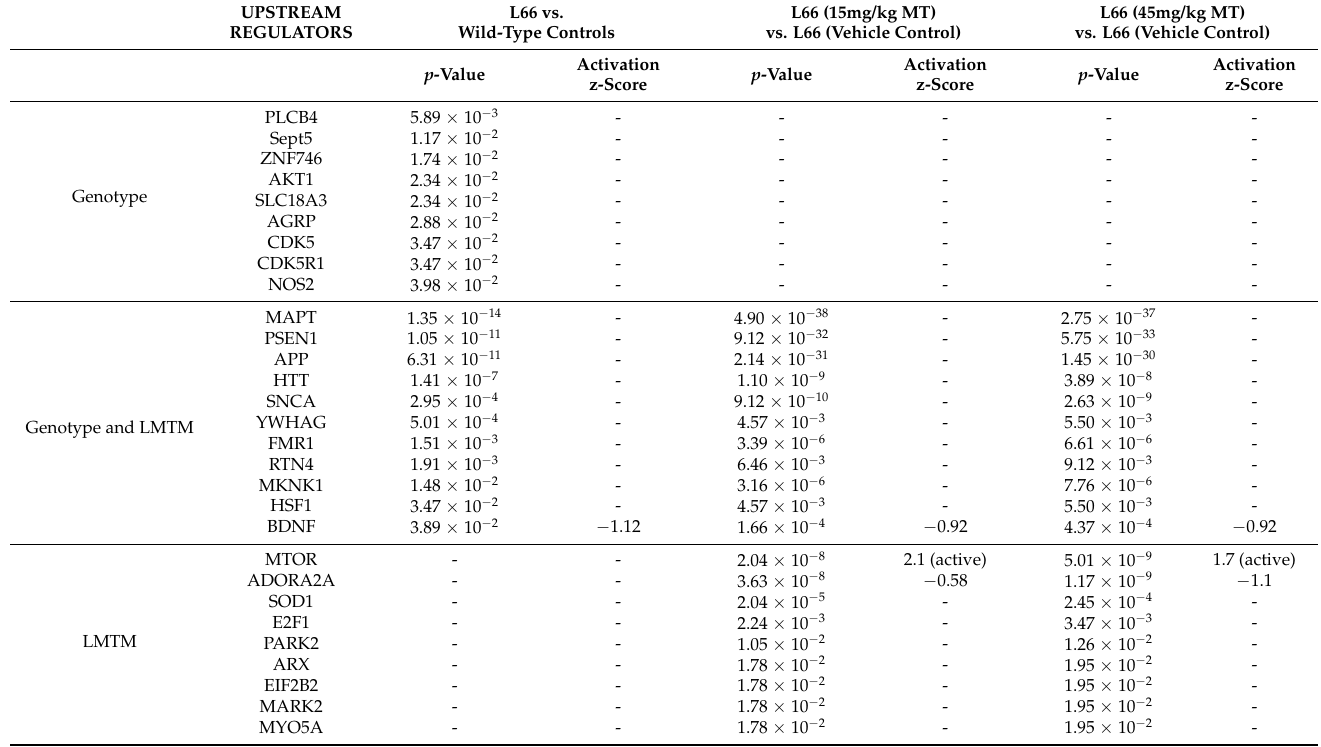
Table 4. Summary of putative upstream regulators identified using IPA Core Analysis. These regulatory molecules are significantly altered and upstream of pathways stated in Table